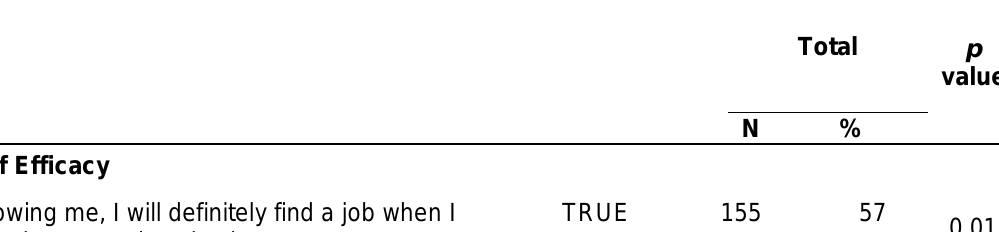
Total p value N %